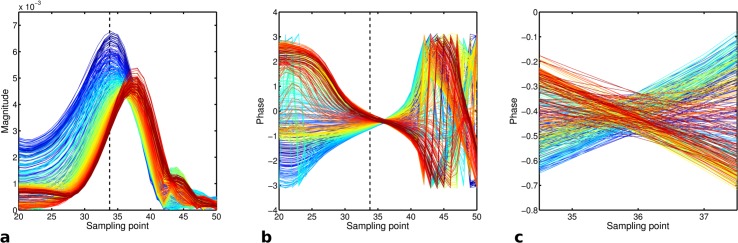
Gradient delay calibration using k-phase: Shown are 45 spokes of the measured calibration data from the x-y plane to illustrate the concept.The magnitude is shown in (a), the phase in (b) and an enlarged central part of (b) is shown in (c). The colors characterize the spoke index using a continuous jet color map where blue is the first and red the last index. The dashed black line marks the expected position of the k-space center.